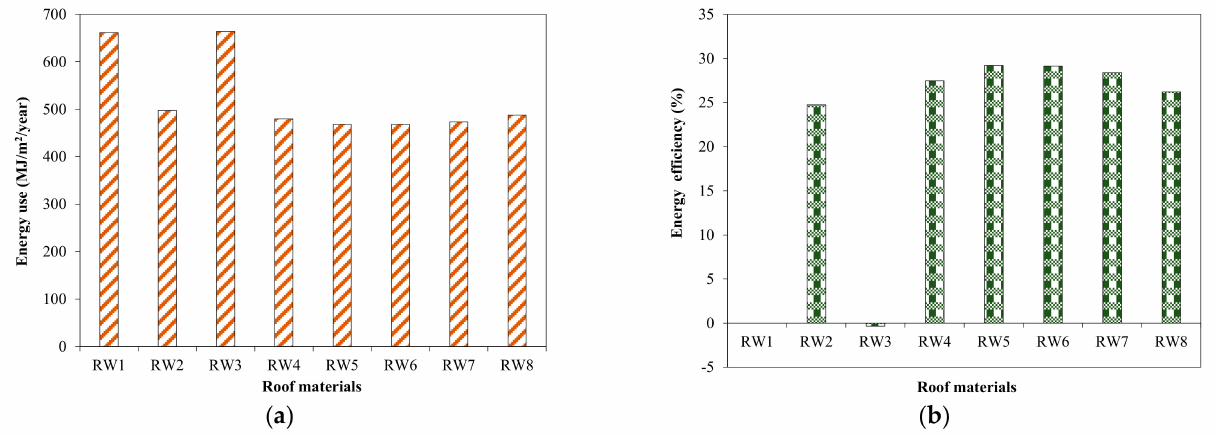
Figure 14. Effect of roof materials on energy use in tested warehouse building. ( a ) Energy use; ( b ) Efficiency.